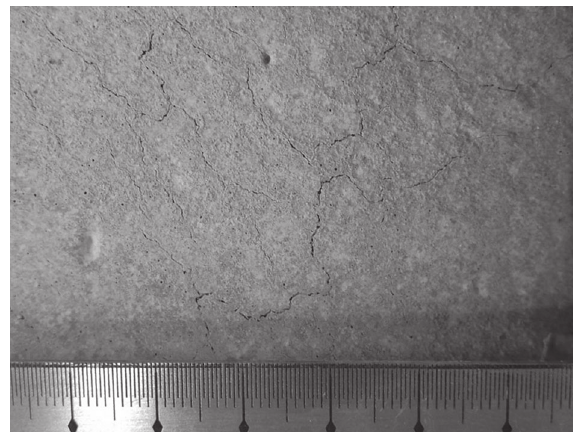
Figure 17: Crack fractures caused by the shower in project 4.